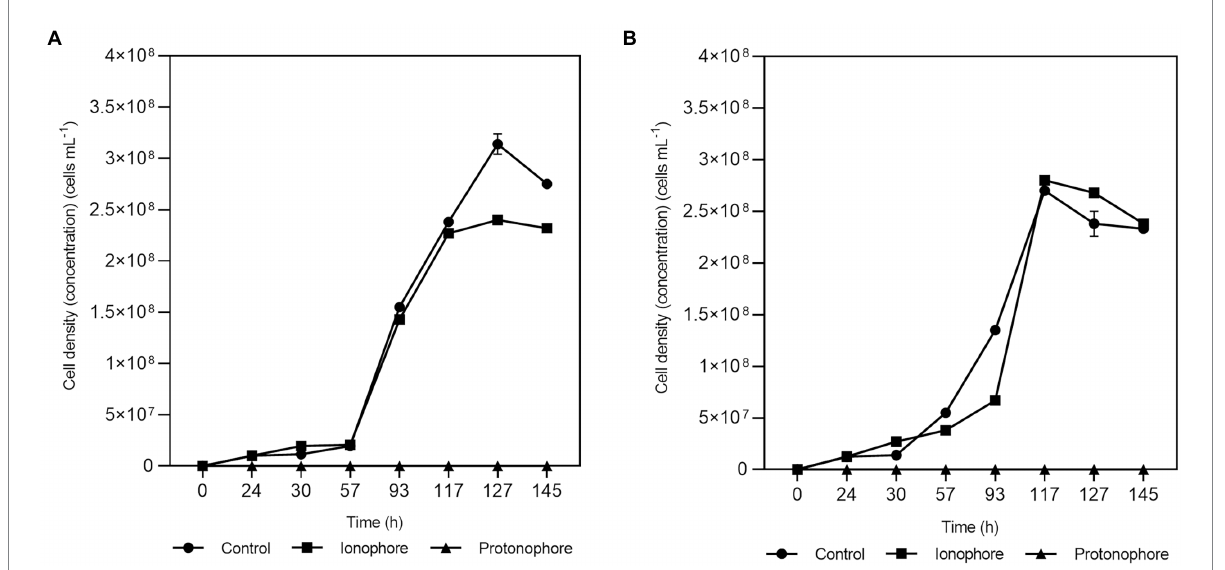
FIGURE 3 Effects of ETH2120 and TCS on Fas growth. Growth curves with lactate-sulfate-arsenate (A) and lactate-arsenate (B) , with addition of 20 μ M ETH2120 as ionophore ( ■ ), 20 μ M TCS as protonophore ( ▲ ) or no addition ( ● ). Error bars show standard deviation of duplicates.